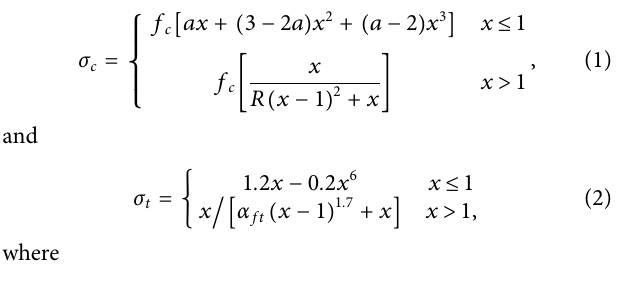
Frontiers in Materials |